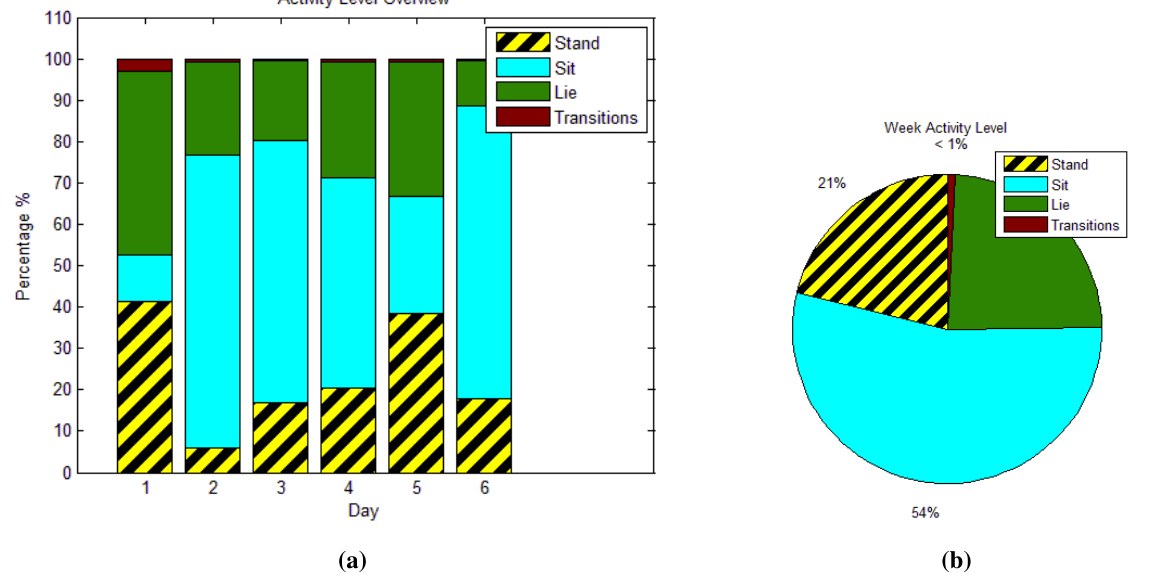
Figure 3. Clinician summary view of the weekly activity of a user from the trial. ( a ) Daily transition and state information of a user from the trial; ( b ) summary of the